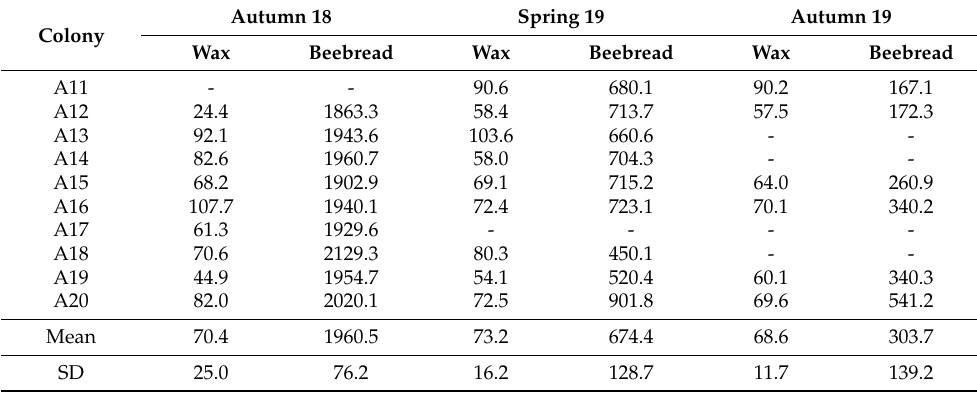
Table 1. Tau-fluvalinate concentration (in ppb) detected in wax and beebread from each honey bee colony included in the study at each sampling point (colony A17 died on March 2019 and was replaced by A11). SD: standard deviation. Autumn 18 Spring 19 Autumn Colony